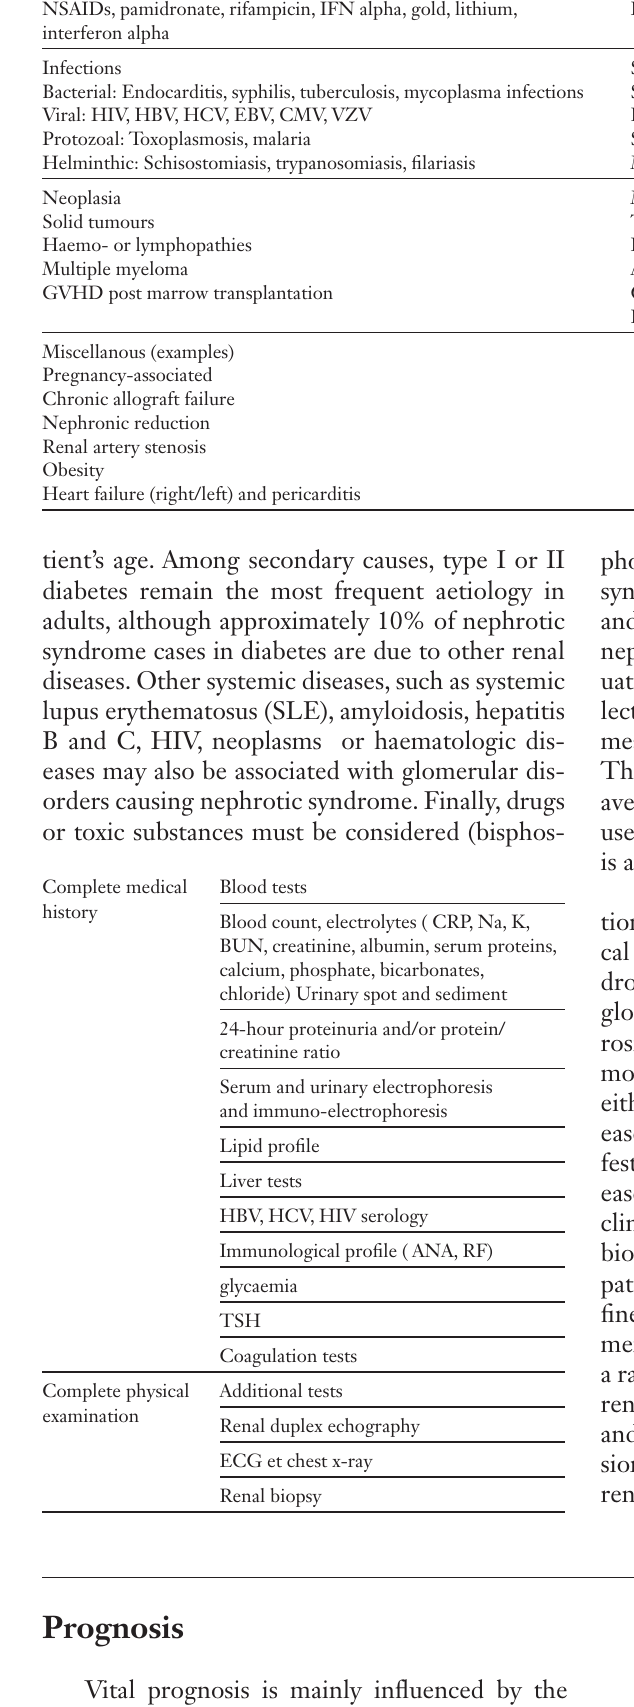
Causes of secondary nephrotic syndrome (most frequent).